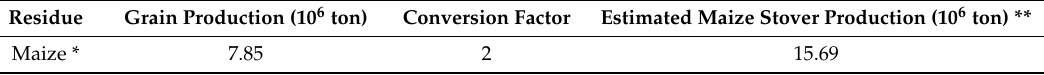
Table A1. National estimates of maize stover produced per annum in the 2016 / 2017 production year in